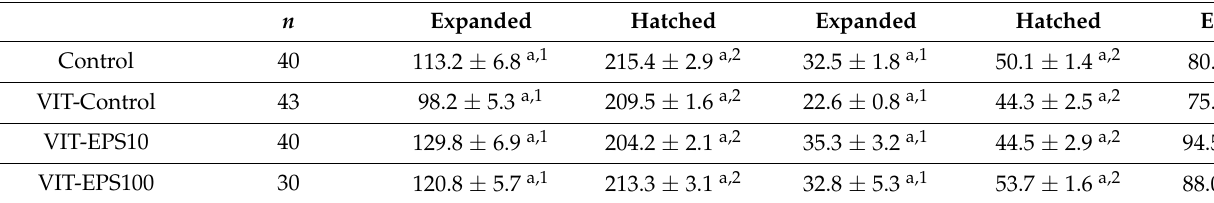
Data are shown as mean ± SEM. a,b,c,d Values within columns with different superscripts indicate significant differences between treatments ( p ≤ 0.05); 1,2 Values within rows with different superscripts indicate significant differences between stages (Expanded and Hatched) ( p ≤ 0.05). TCN: Total cell number; ICM: Inner Cell Mass; TE: